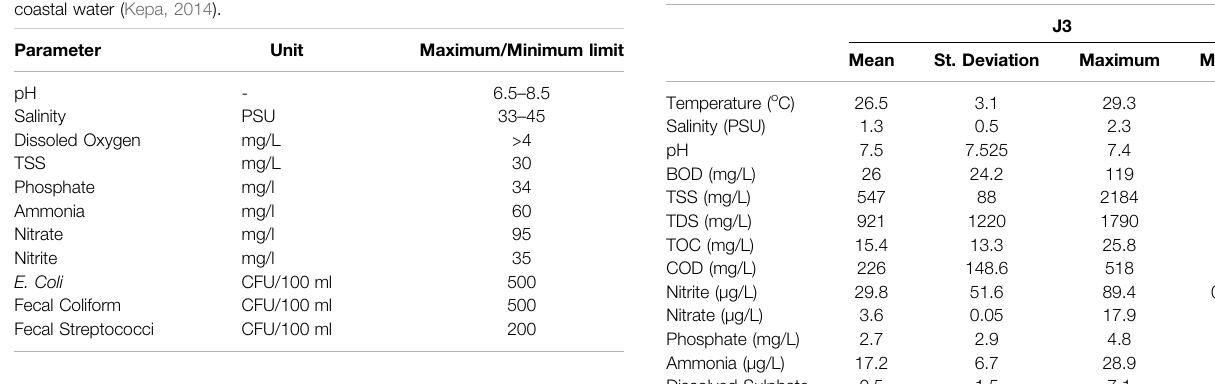
TABLE 4 | Statistical summary of water quality from J3, J4, and J5